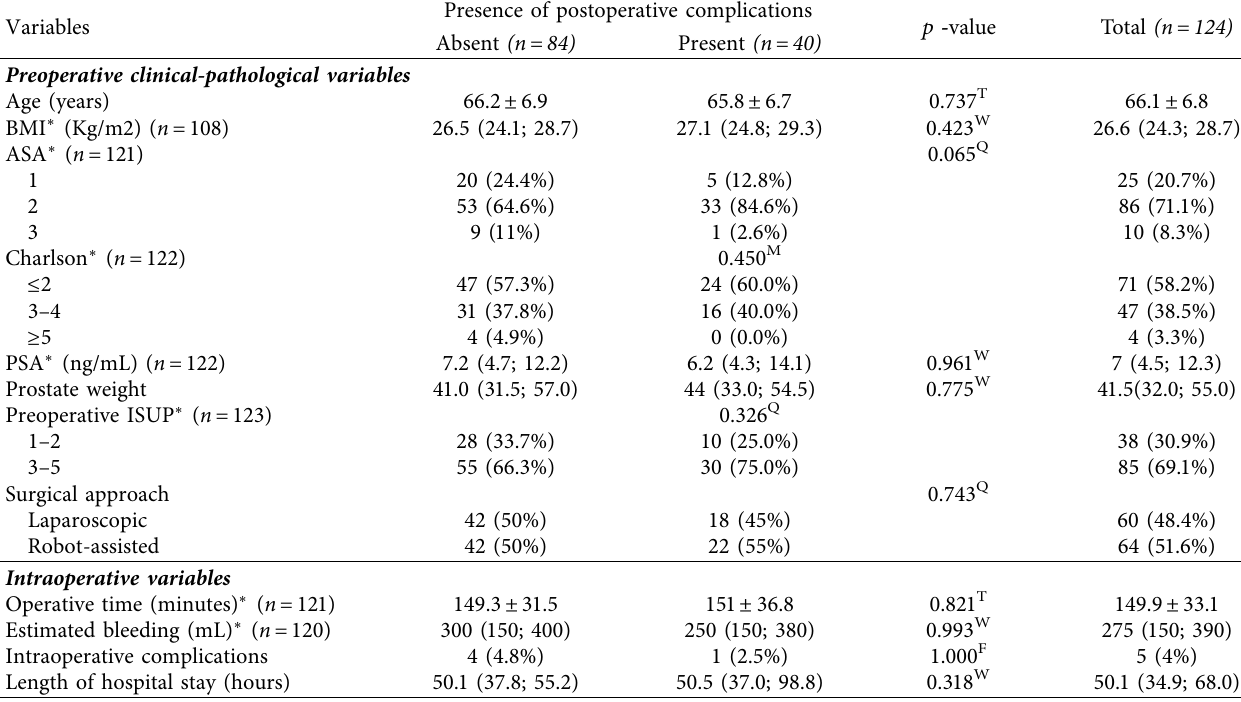
Table 1: Univariate analysis of clinical-pathological variables in the pre and intraoperative period and the occurrence of postoperative complications.